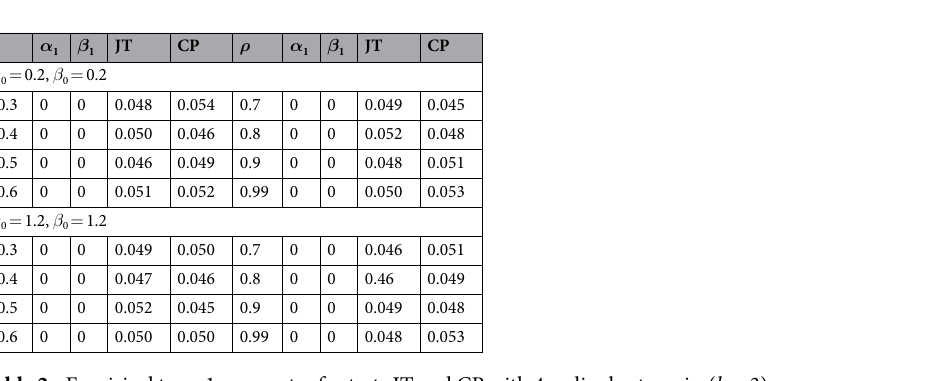
Table 2. Empirical type-1 error rates for tests JT and CP with 4 ordinal categories( k =